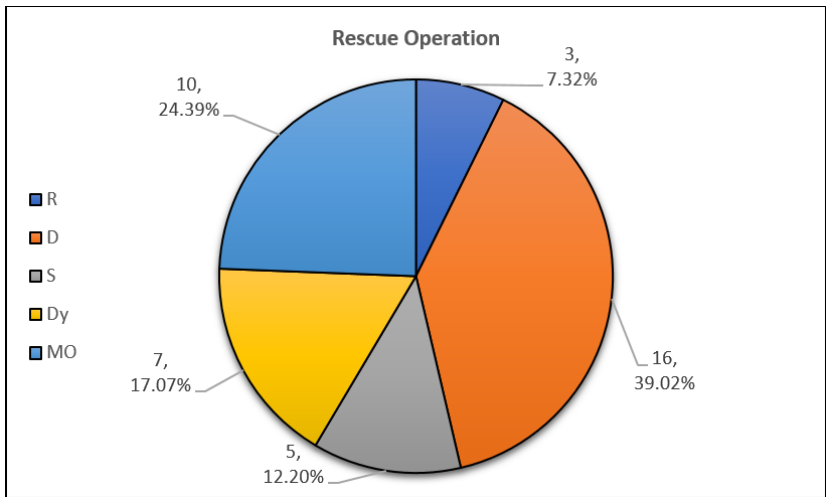
Figure 22. Breakdown of VRP for Rescue Operation based on Modelling Aspect.